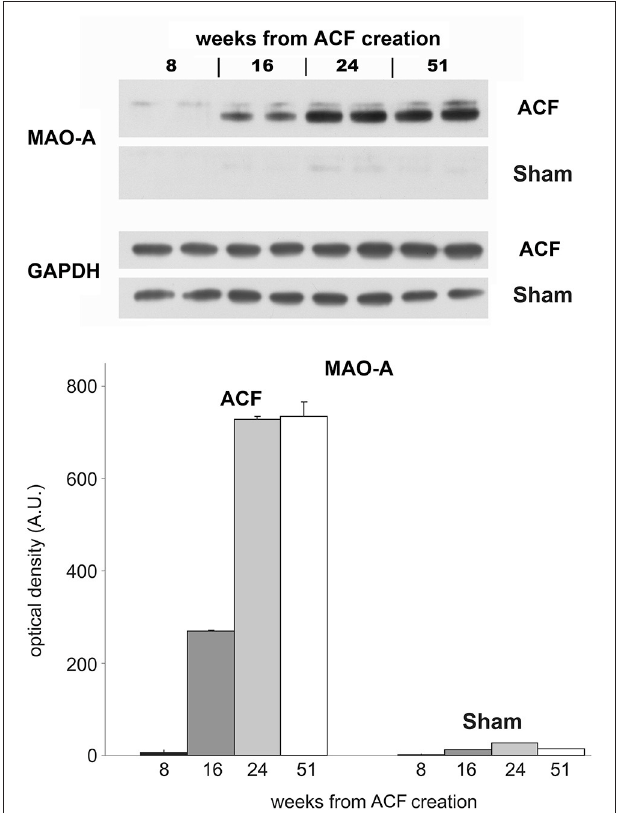
FIGURE 5 | Longitudinal changes in MAO expression in the ACF model. Western blot was performed with samples from left ventricles of animals with ACF and sham-operated animals (animals sacrificed 8, 16, 24, and 51 weeks after creation of ACF). Each sample represents a pooled tissue homogenate from five animals from the individual group. Samples were loaded in duplicates on the 10% minigels. As a primary antibody rabbit anti-monoamine oxidase A was used (MAO-A, 1:333, Sigma-Aldrich, MO,